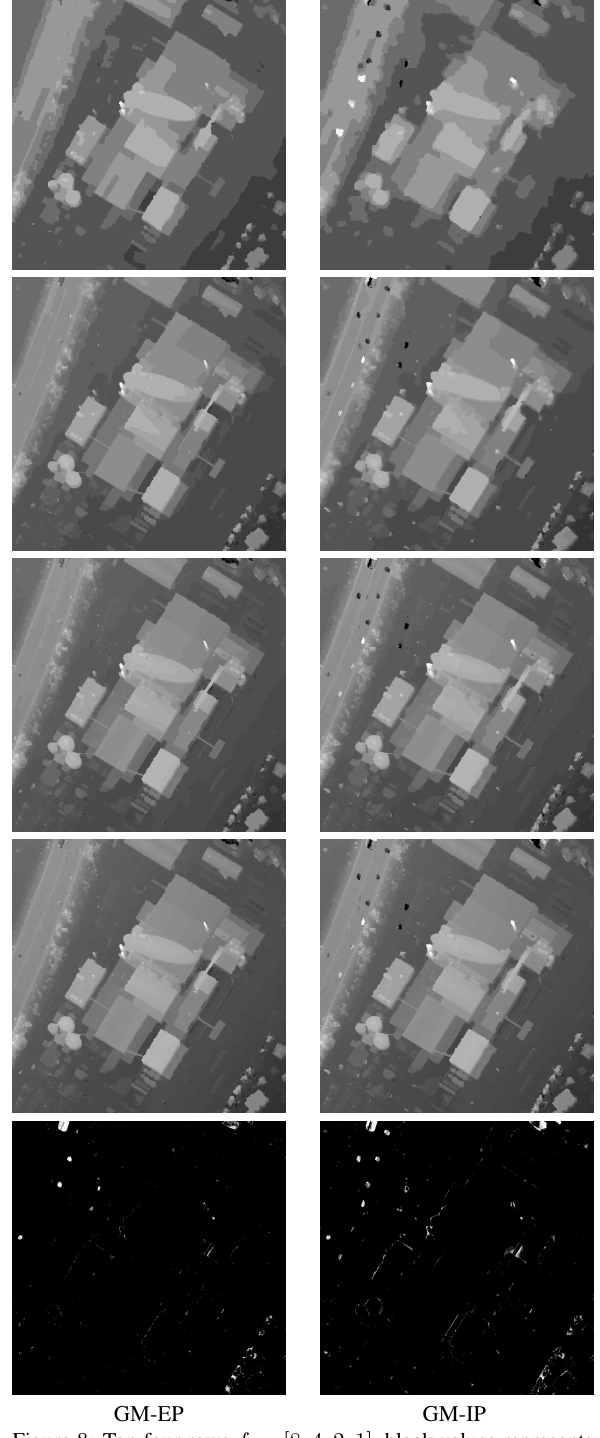
Figure 8: Top four rows f = [8 , 4 , 2 , 1] , black values represents disparities of -15 pixels or below, and white values represents disparities of 35 pixels or above. Last row absolute difference with respect to the baseline, brighter greys are higher difference. left image of Fig. 10. The edges produces by the GM-EP are sharper and better